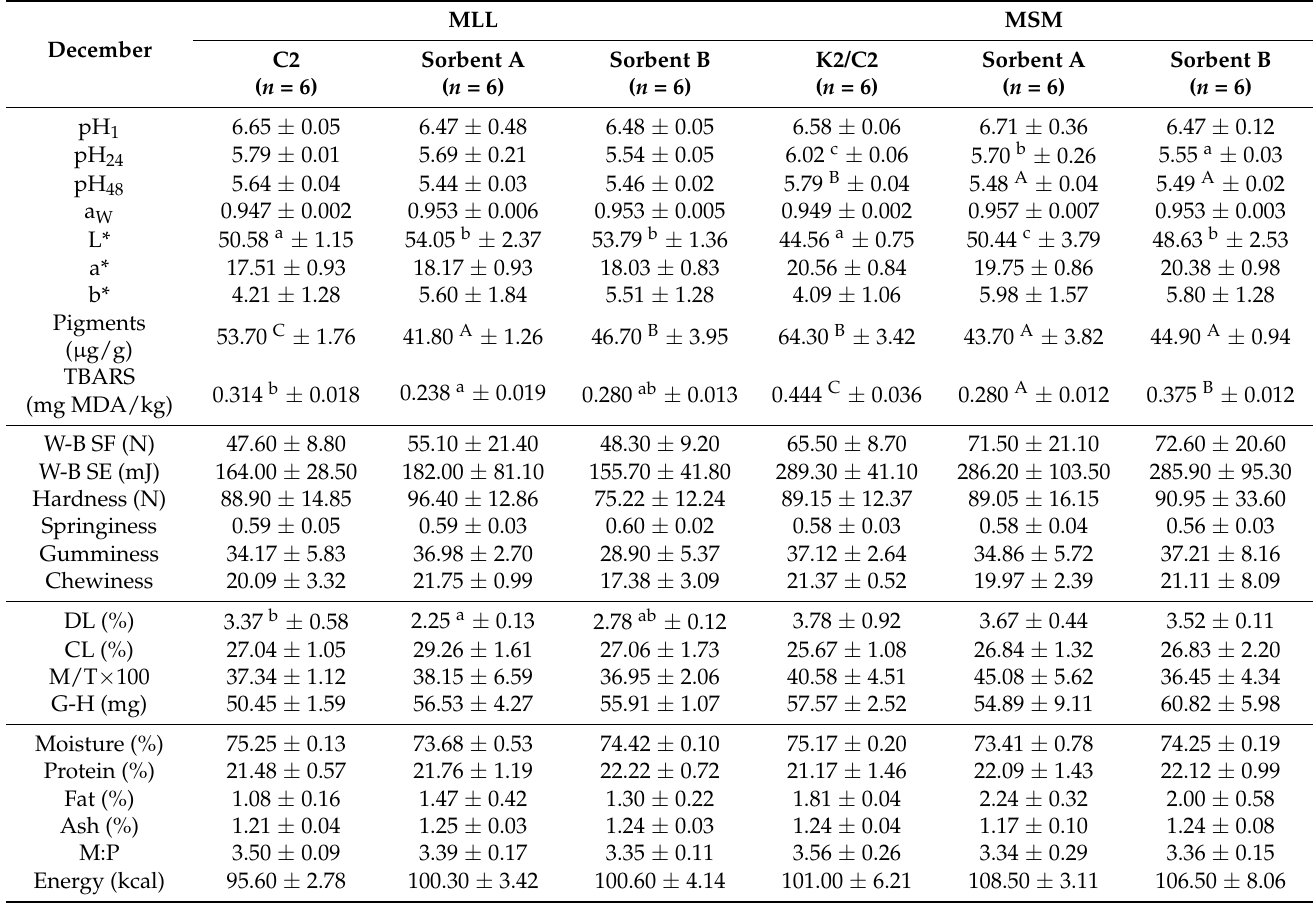
Table 4. Physicochemical properties of the musculus Longissimus lumborum (MLL) and musculus semimembranosus (MSM), (mean ±